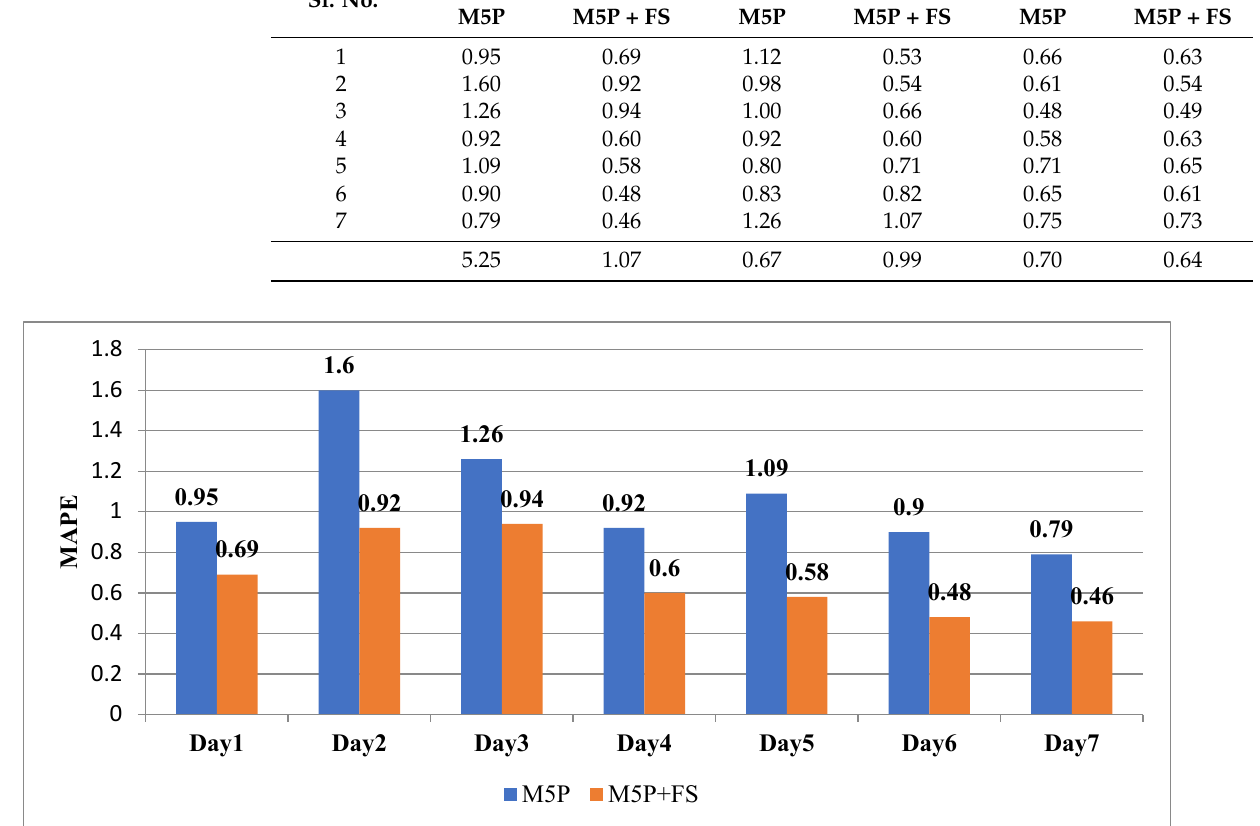
Table 7. Daily MAPE for all seasons corresponding to M5P and M5P + FS. Sr. No.